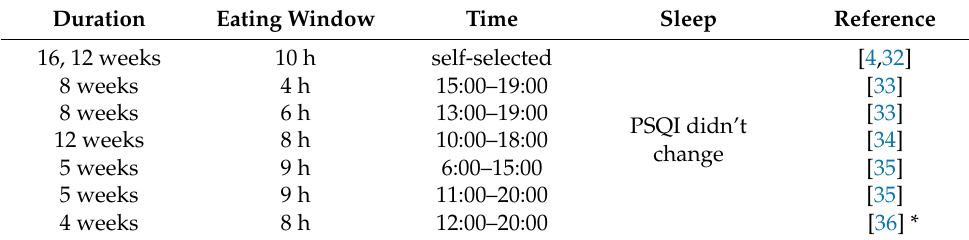
Table 1. List of time-restricted eating